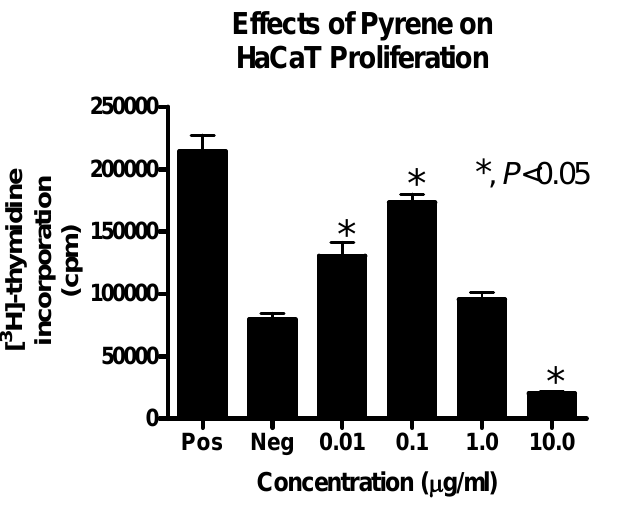
Figure 2: Effects of pyrene on HaCaT proliferation. HaCaT cells were grown in 35mm plates to subconfluent in CGM. Cells were serum starved for 24 hours and then treated with pyrene at 0.01, 0.1, 1.0 and 10.0 μ g/ml concentrations for 18 hours. Thymidine incorporation assay was then performed as described in materials and methods. Results represent the mean +/- SD values of experiment performed in triplicate. [* indicates that treatment mean is significantly different from negative control according to Dunett test ( p<0.05 )].